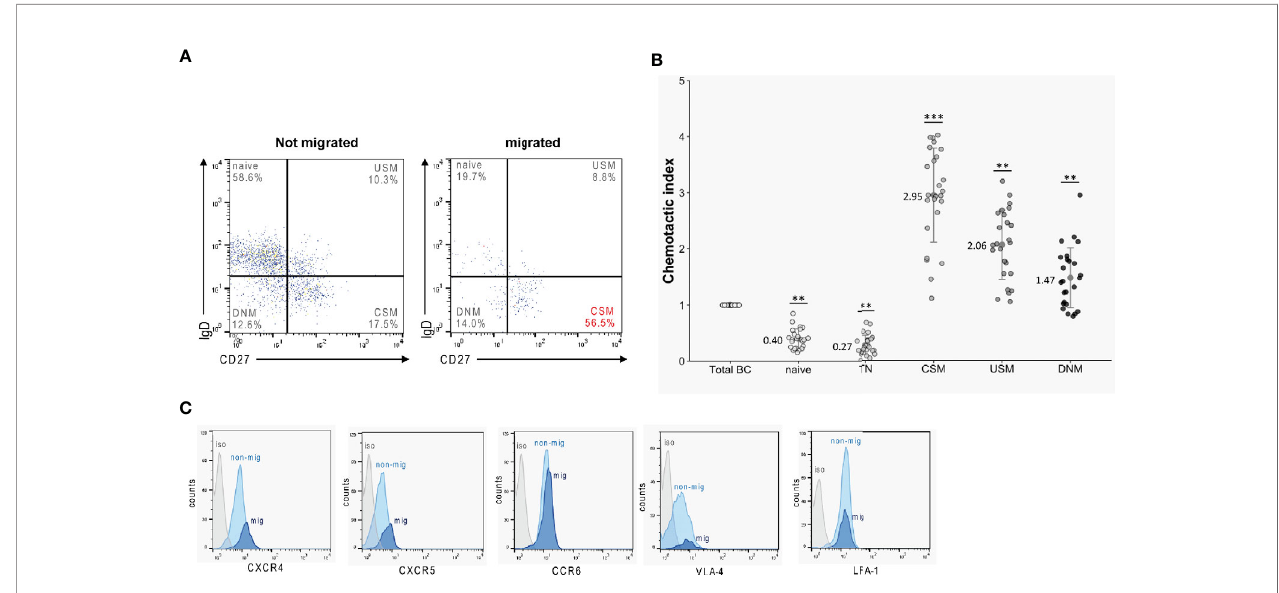
FIGURE 3 | Transmigration rates of B-cell subsets. B cells obtained from healthy donors ( n = 25) were tested in TM assays against a mix of CXCL12 and CXCL13. Migrated and non-migrated cells were then phenotypically characterized by fl ow cytometry. (A) Migrated cells were highly enriched for class-switched memory B cells (CSM). (B) Superior chemotactic activity (CI) of memory B-cell subsets (CSM, class-switched memory; USM, non-switched memory; DNM, double negative memory) versus naïve subtypes (TN, transitional). All experiments were carried out in triplicates. Dots represent data per individuals. Dots represent data per individuals. Means are indicated (grey circles). Error bars denote SD. Asterices indicate statistical signi fi cances compared with spontaneous TM (*** P < 0.001, ** P < 0.01; one-way ANOVA plus post Hoc Tukey test). (C) Surface expression of CXCR4, CXCR5, CCR6, VLA-4 and LFA-1 on migrated (mig, light blue) and non- migrated (non-mig, light blue) CSM B cells obtained from healthy donors ( n = 10) as determined by fl ow cytometry. (Isotype control = iso, in